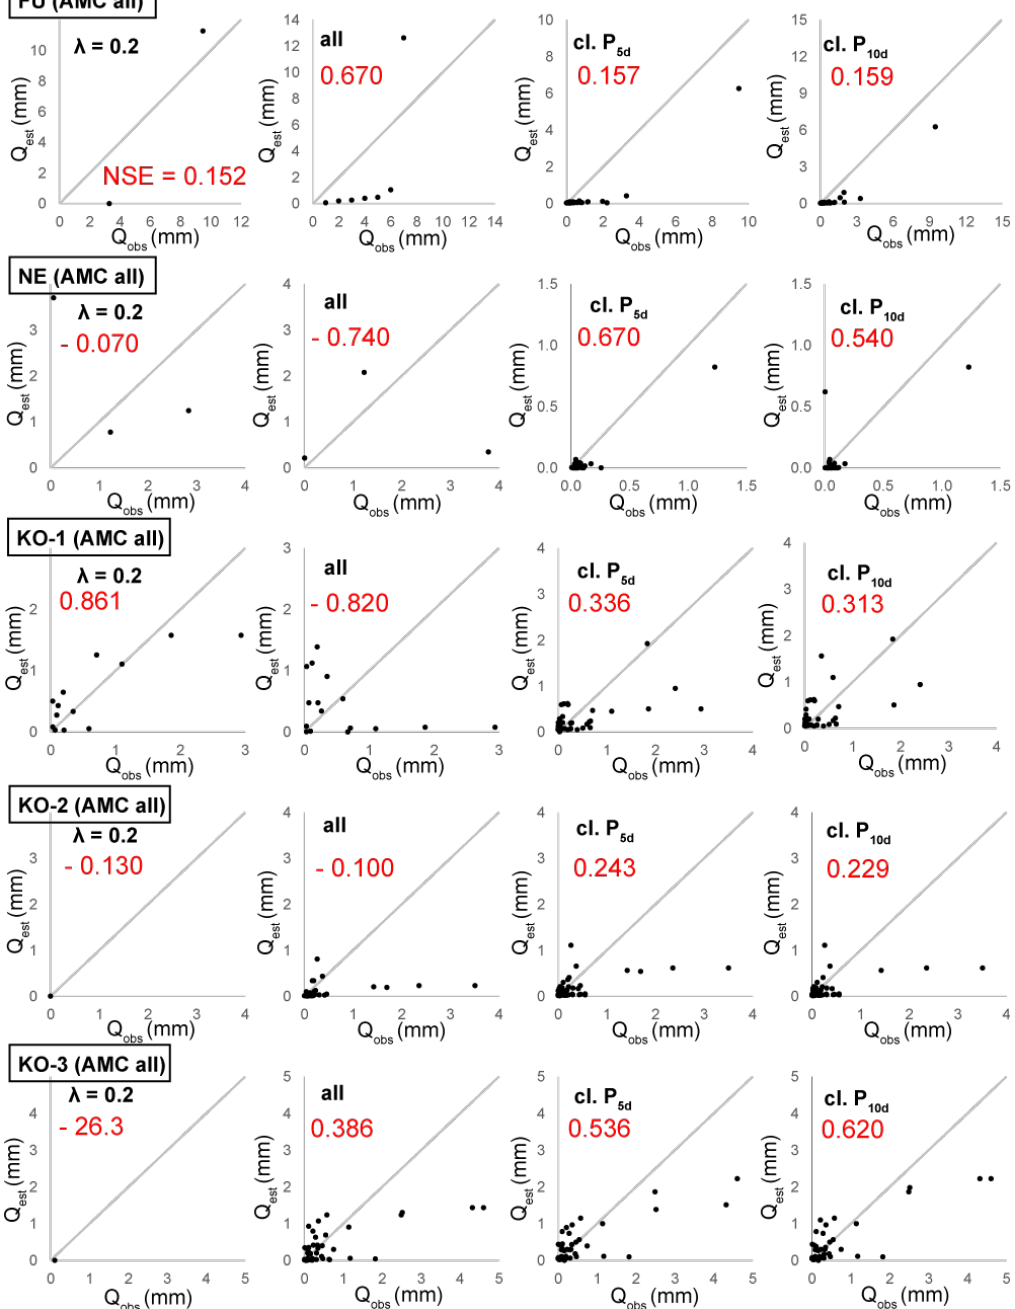
Figure 5. Comparison of observed direct runoff heights (mm) with those simulated in the experimental catchments using regressions of λ according to P for events with AMC classified (AMC all). Comparison of direct runoff estimates with AMC not classified (AMC = II) is provided in Figure S2.